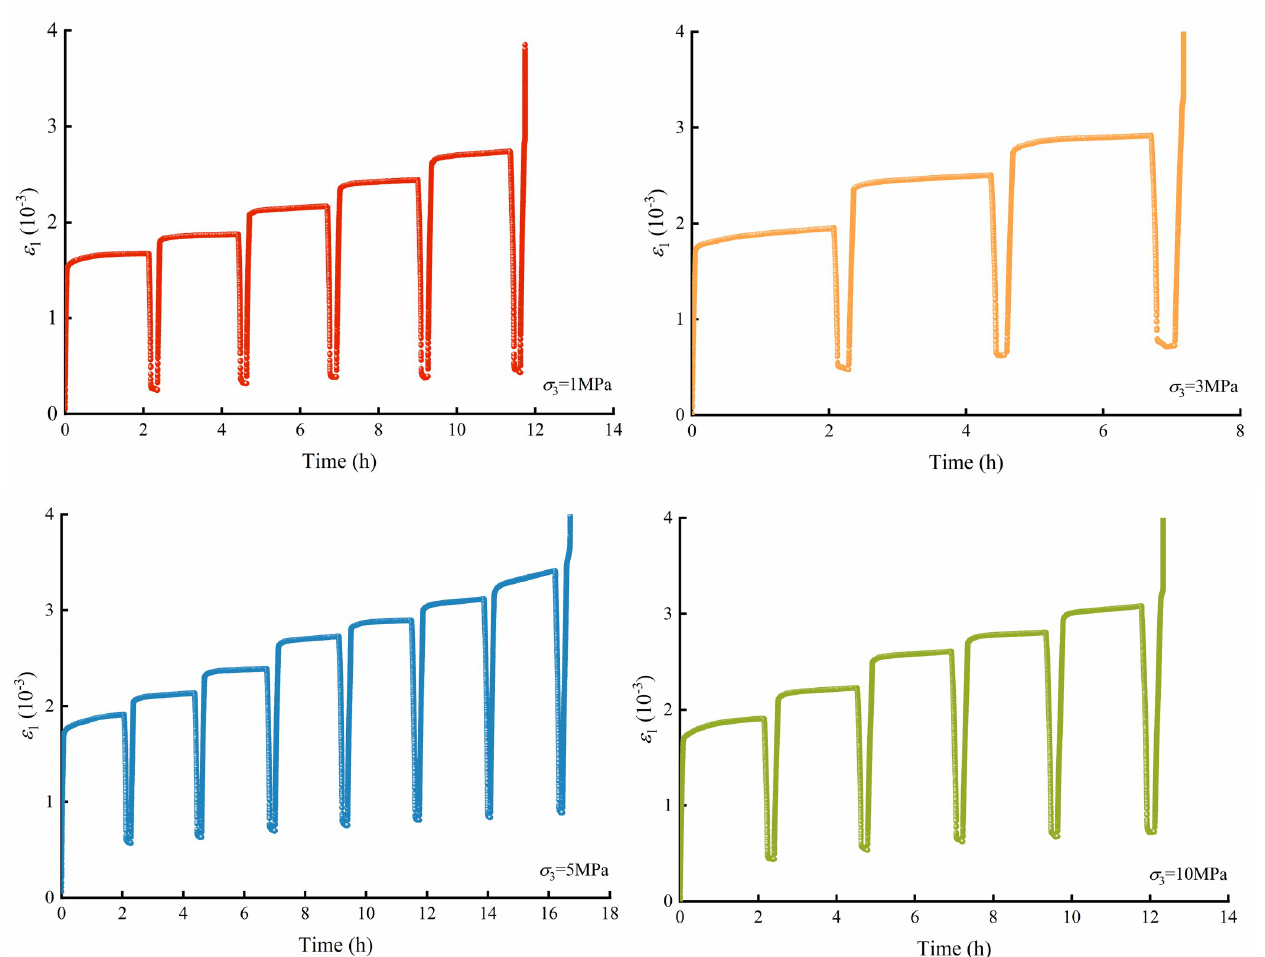
Fig 5. Crack strain evolution